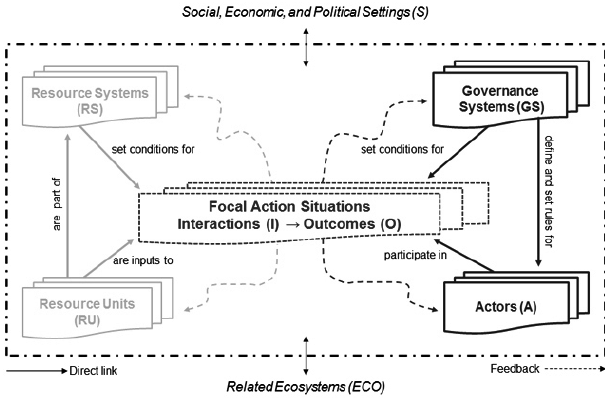
Fig. 2. Institutional analysis and development representation of social-ecological systems. Source: Ostrom and Cox